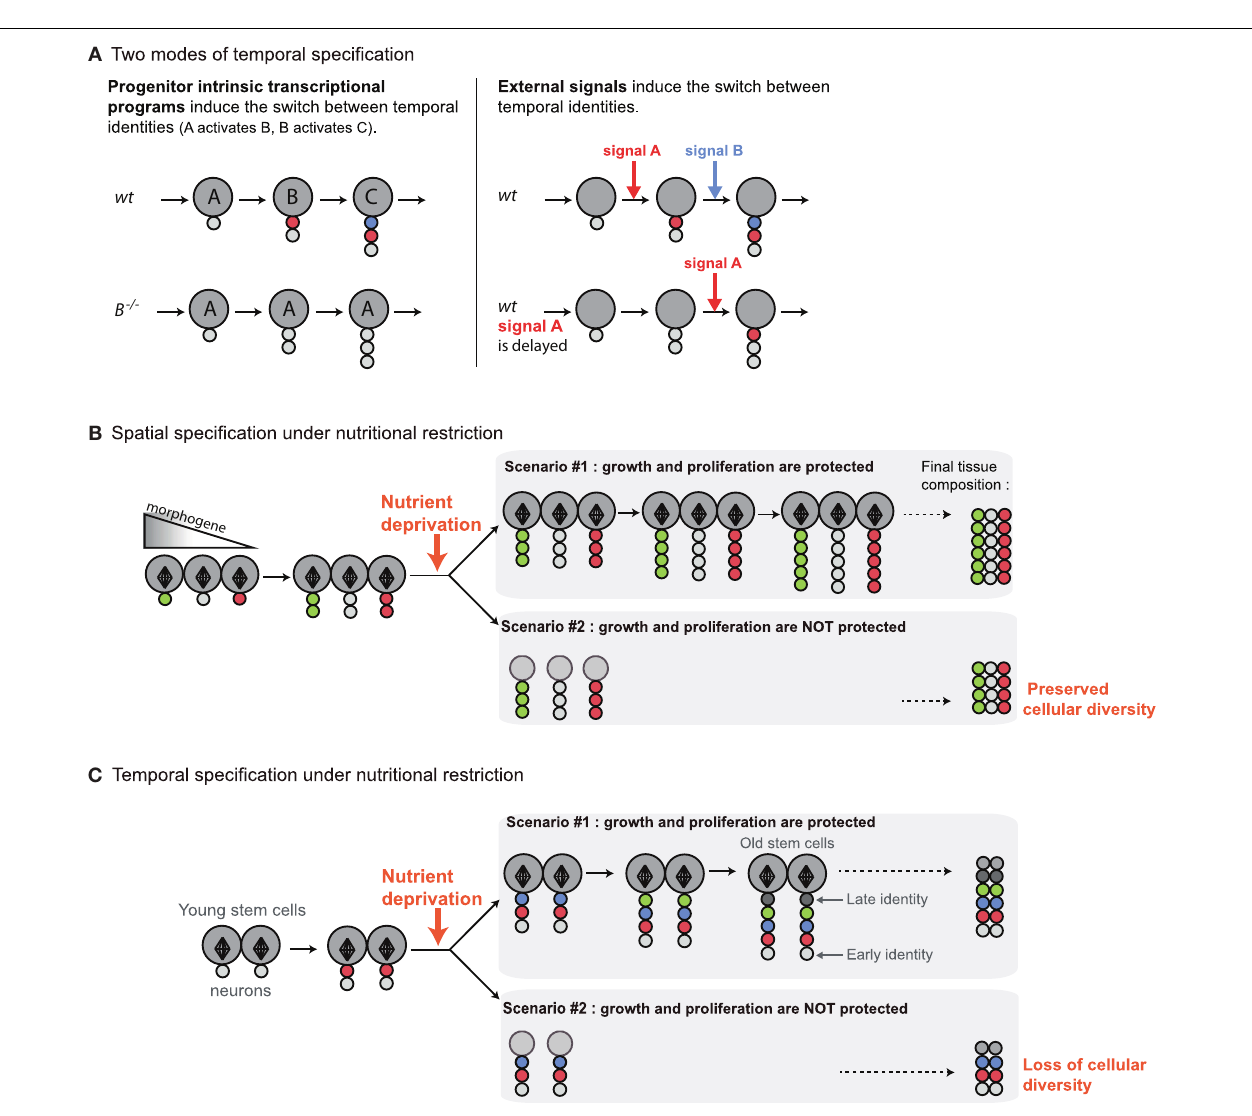
FIGURE 2 | Distinct mechanisms for promoting cell diversity during development imply distinct responses to nutrient deprivation. In the subsequent figures, large circles represent neuroblasts and small circles, their differentiated progeny. Diamond shapes represent mitotic spindles of actively dividing progenitors. The various colors in differentiated progeny depict different neuronal identities in the lineage. (A) Two modes of temporal patterning have been described in Drosophila . In most lineages, progenitor intrinsic transcriptional programs regulate the sequential expression of “temporal” transcription factors (A, B, C) that specify distinct neuronal identities in the successive neuroblast progeny. Mutations in temporal transcription factors block the sequential expression of late factors and lead to neuroblasts that continuously generate progeny of the corresponding identity. On the other hand, in other lineages such as in the mushroom